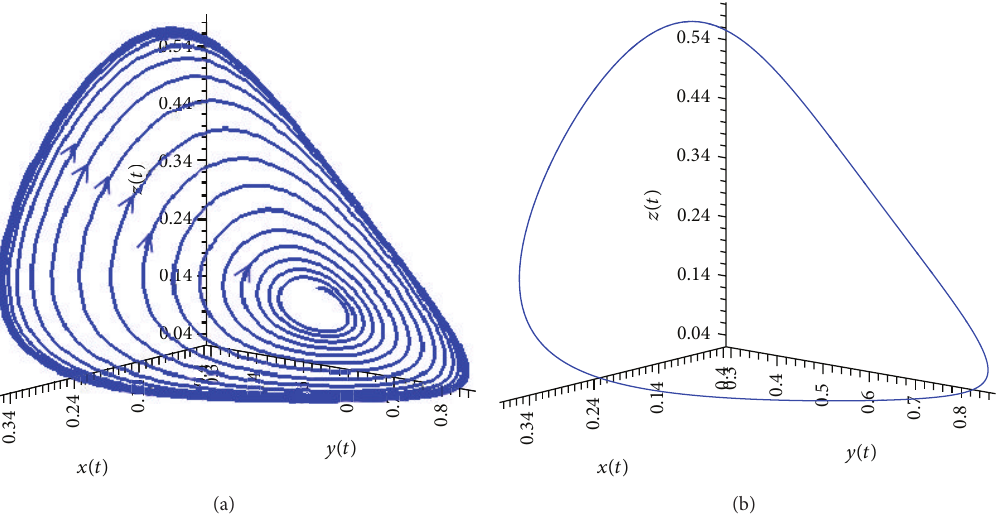
Figure 2: Phase portrait of system (1) near the equilibrium 𝐺 , with initial conditions: (0.1325, 0.66, 0.19) . (a) 𝐺 is an unstable focus for 𝑎 = 0.8 . Integrationtime: [50, 500] .(b)LimitcyclecreatedwiththeHopfbifurcationthatoccurswhen 𝑎 passesthroughthecriticalvalue 𝑎 = 0.717455 . Integration time: [450, 500]